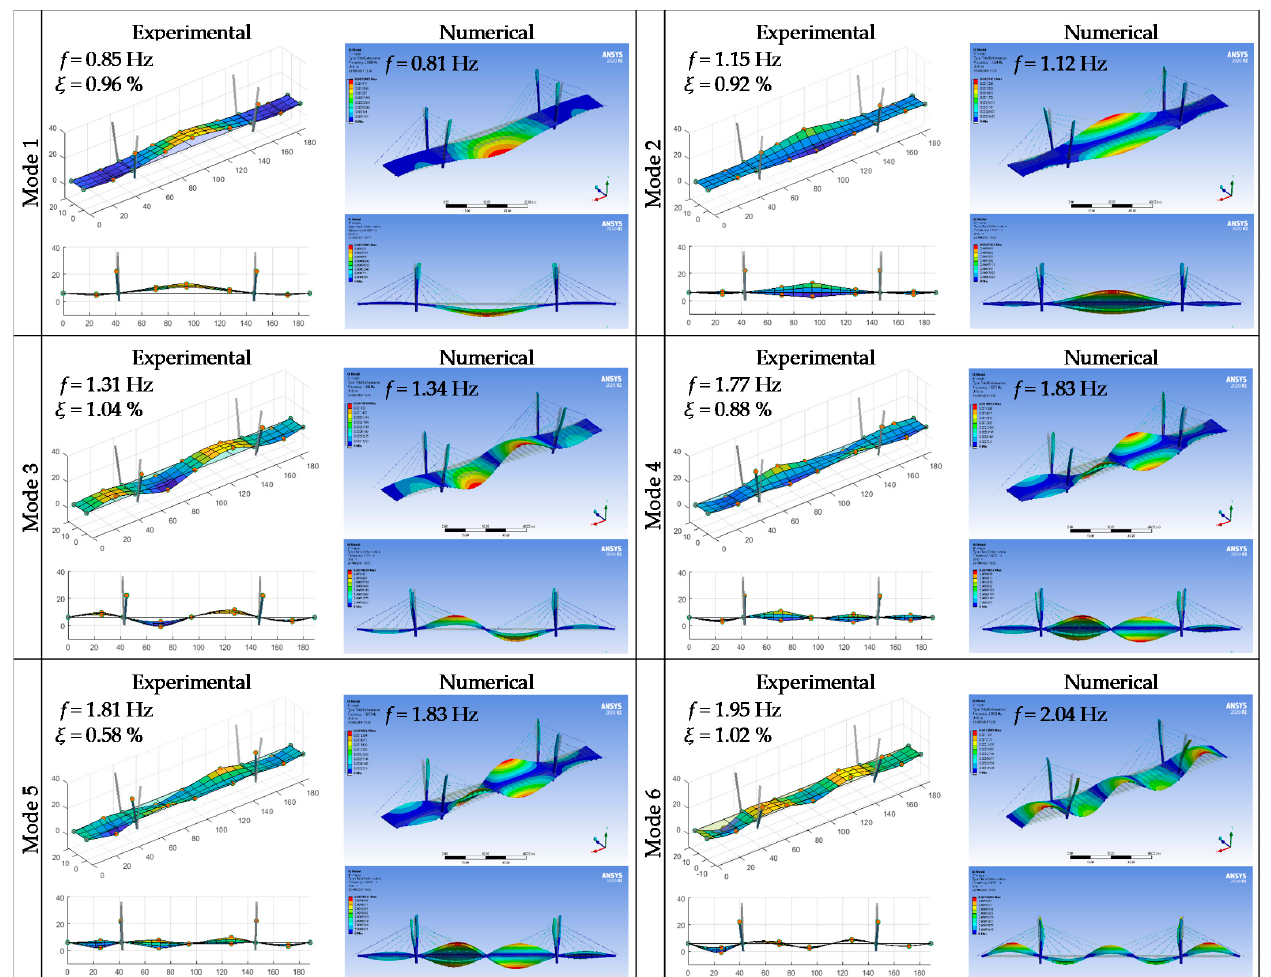
Figure 15. Example of stabilization diagram that was obtained for the identification procedure of the Dyn.1 test.